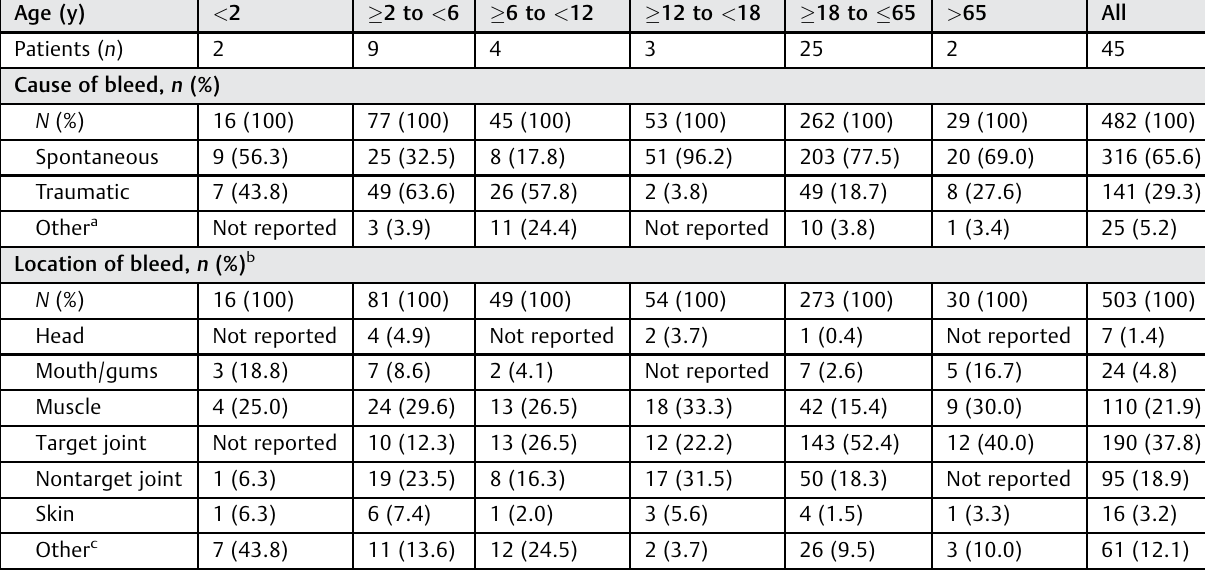
Table 1 Characteristics of bleeding episodes treated with rFVIIa (NovoSeven ® ) monotherapy in SMART-7 ™ overall and by age group <